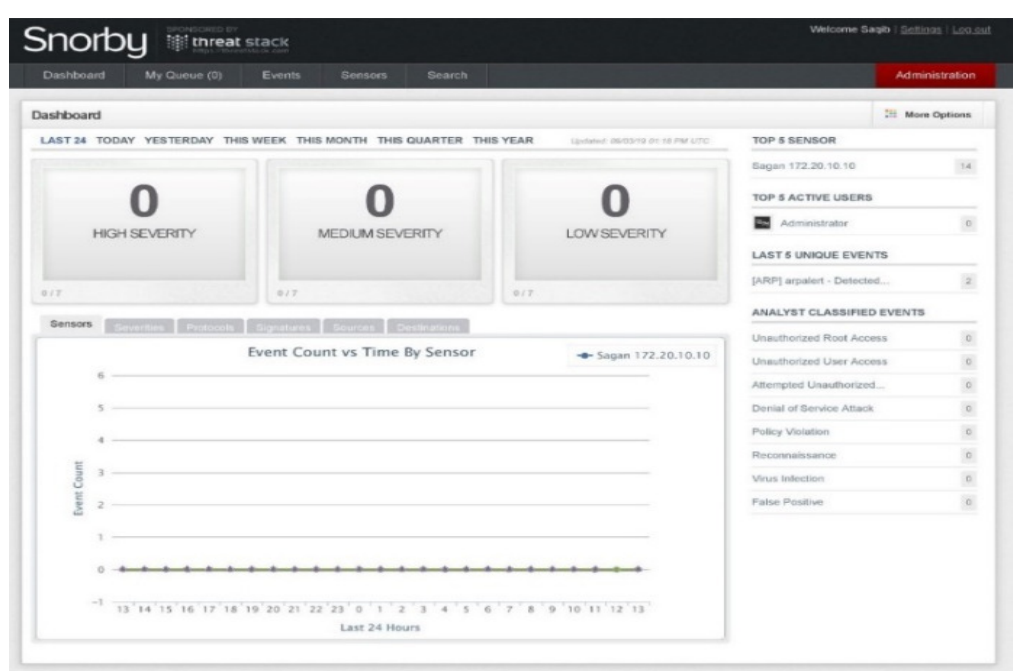
Fig 12: Snorby web dashboard to show normal traffic before the